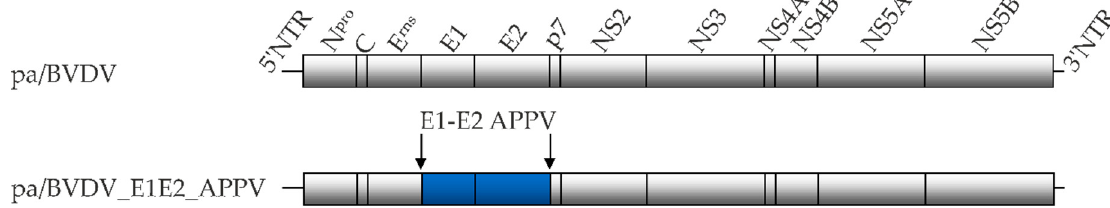
Figure 1. The genome structure of the parental full-length cDNA clone pA/BVDV and the generated chimeric construct pa/CP7_E1E2_APPV. Blue-colored boxes represent the substituted APPV structural proteins E1 and E2. Lines at the left and right ends demonstrate non-translated regions (NTRs).